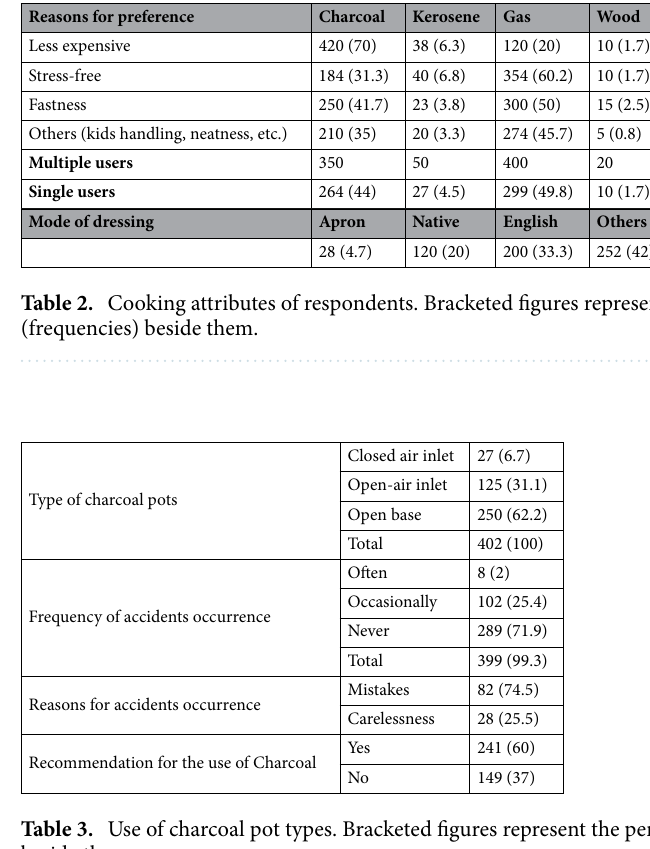
Table 3. Use of charcoal pot types. Bracketed figures represent the percentages of each figure (frequencies) beside them.